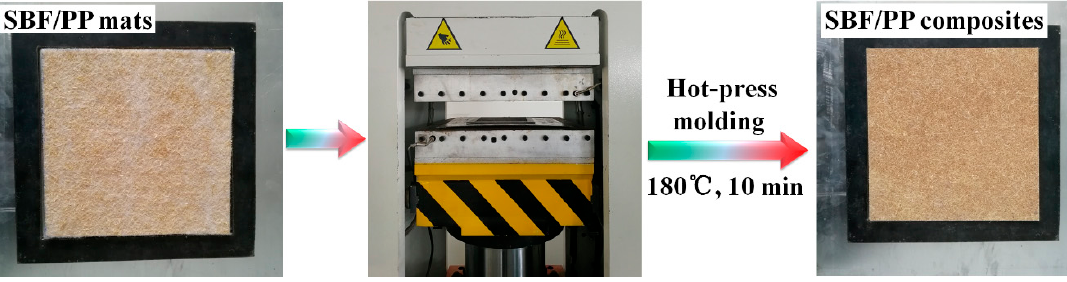
Figure 3. Graphical illustration of SBF / PP